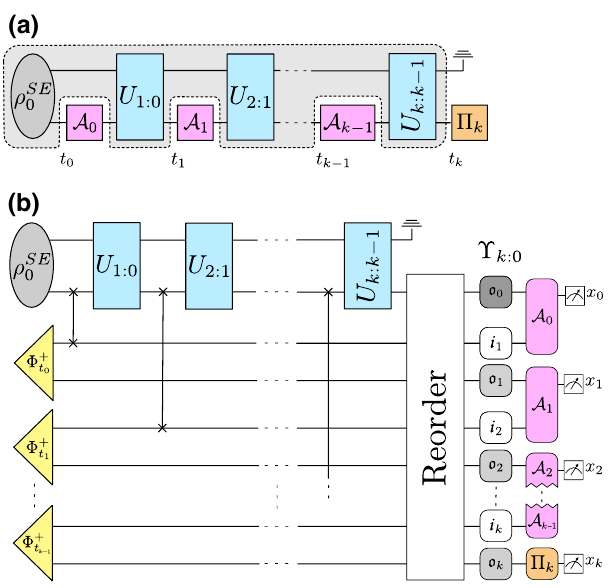
FIG. 1. The process-tensor description of open quantum sys- tems. (a) A circuit-form depiction of the process tensor. The unitaries U j : j − 1 describe arbitrary SE dynamics. Control oper- ations A j are implemented at times t j . Measurement outcomes at each time generate a probability distribution conditioned on the set of controlled operations. (b) A k -step process-tensor Choi is swapped in at each time state. One half of a fresh Bell pair (cid:4) + t j t j . Temporal correlations are then mapped to spatial correlations in the Choi state. Projecting the Choi state onto the Choi state of the controlled operations corresponds to sampling from the many-body